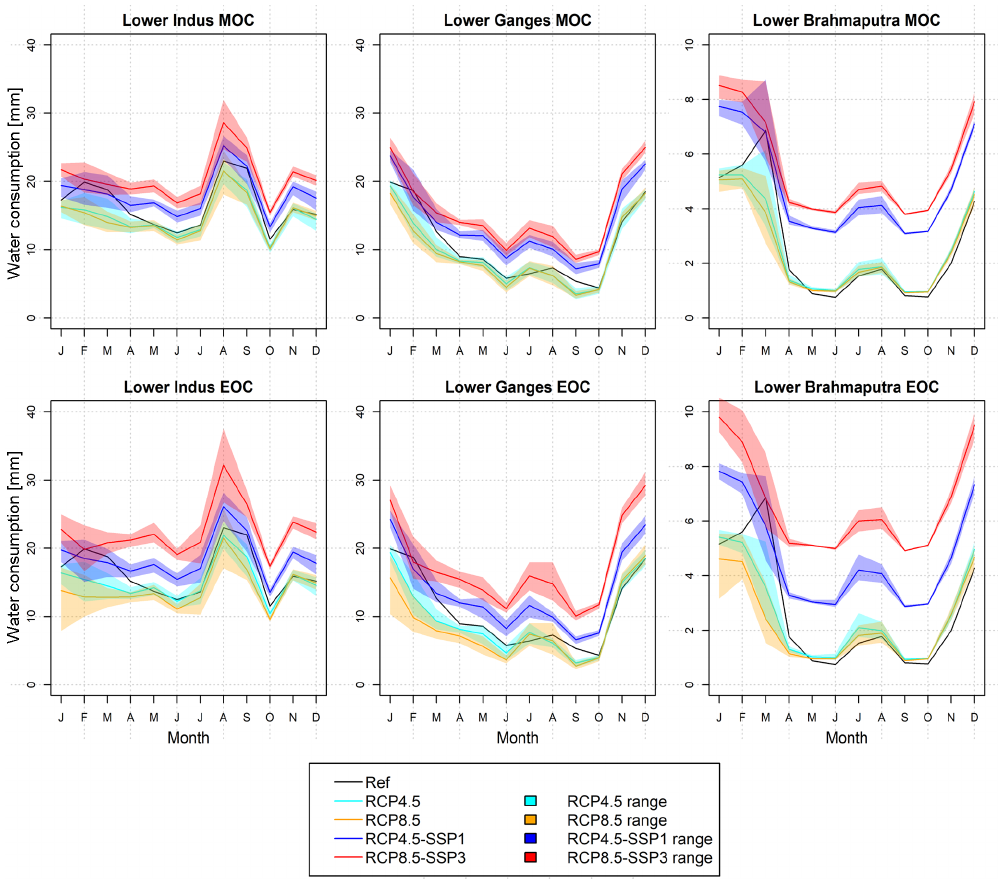
Figure 7. Monthly projected changes in the total water consumption for RCP4.5, RCP8.5, RCP4.5-SSP1, and RCP8.5-SSP3. The projected changes are given for the mid-21st century and end of the 21st century (MOC and EOC). The coloured bands represent the range of ensemble projections that are resulting from forcing the LPJmL model with the different climate models.